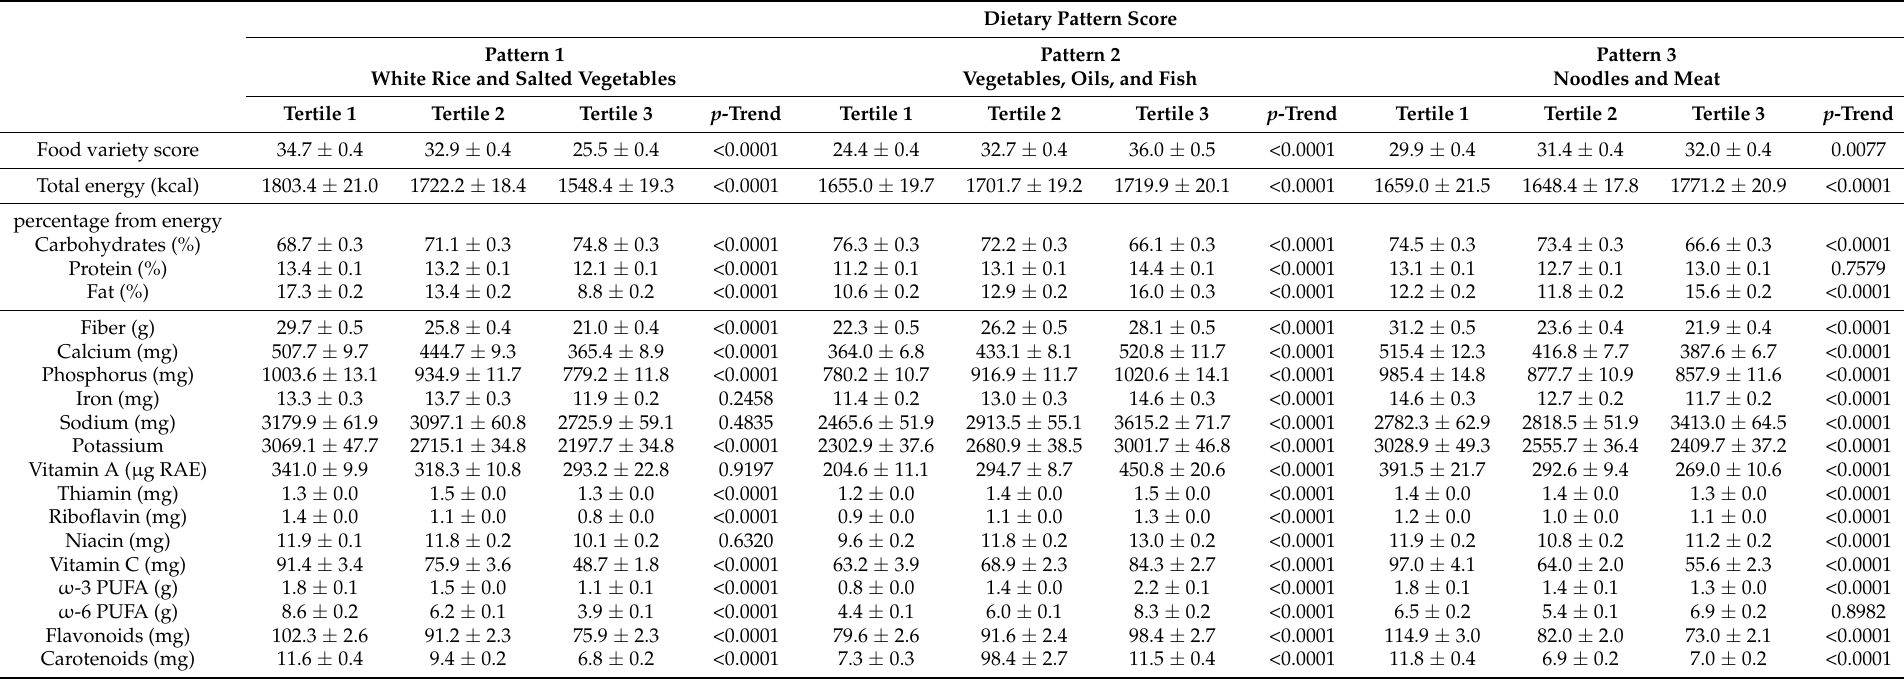
Dietary Pattern Score